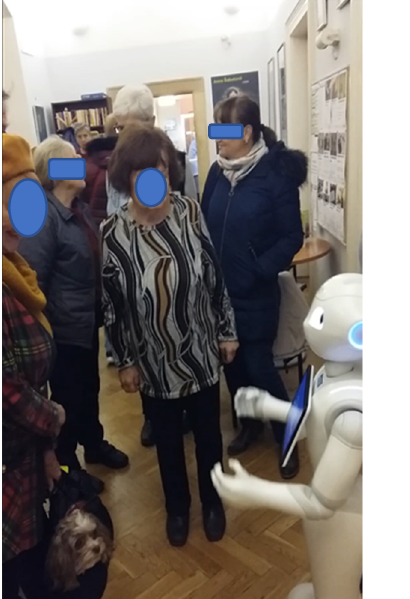
Figure 1a–c: The dynamic of the human bodies in relation to the object-body of the robot Pepper.